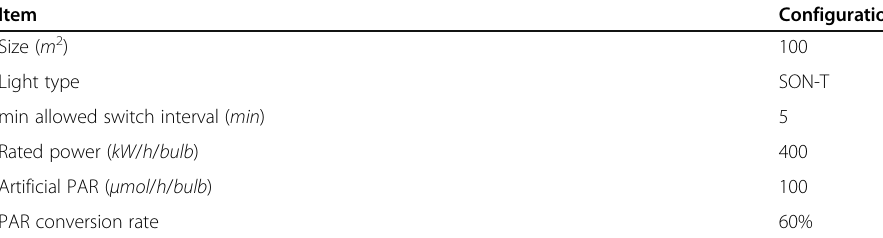
Table 3 Environmental configuration of short-day